Question: What direction does the quantity move in — increasing or decreasing?
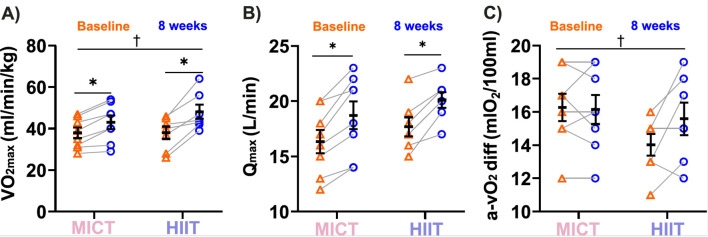
Answer: increasing